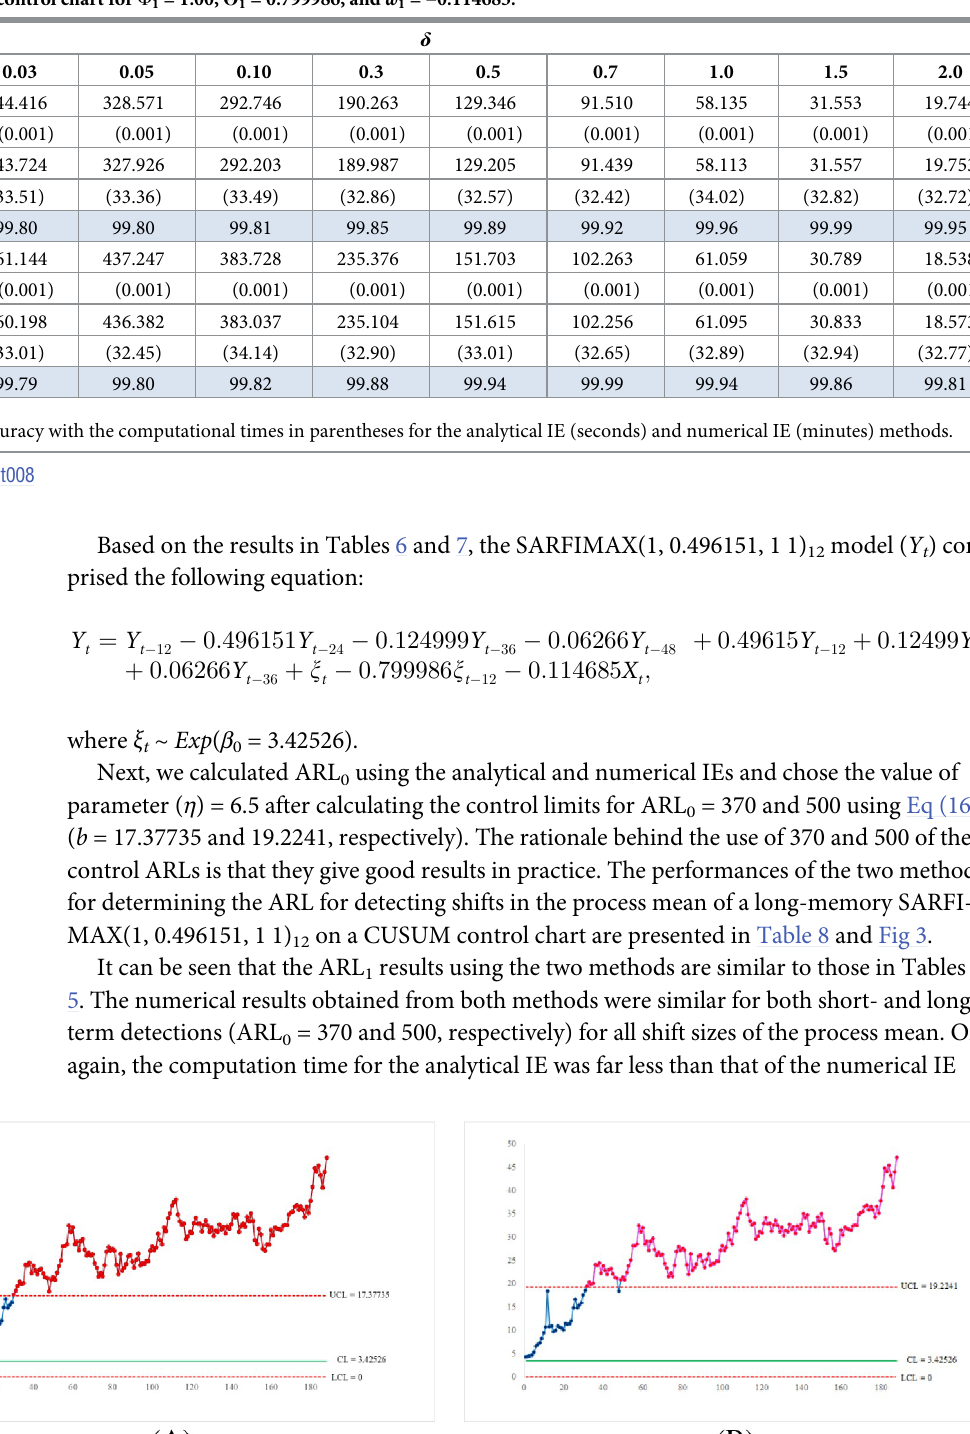
Table 8. Comparison of the ARL 1 values obtained via the analytical and numerical IE methods for detecting changes in the mean of the long-memory SARFIMAX (1, 0.496151, 1 1) 12 process on a CUSUM control chart for F 1 = 1.00, Θ 1 = 0.799986, and ω 1 = − 0.114685.